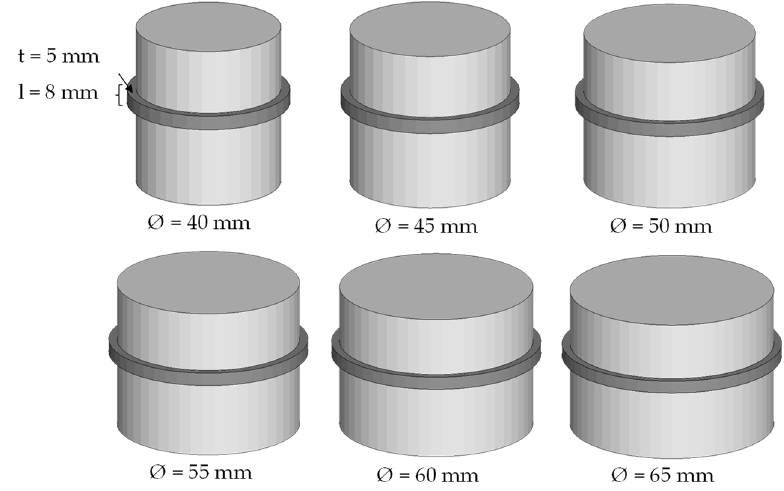
Figure 7. Tools and beads of different diameters while keeping a constant length and thickness of the beads.